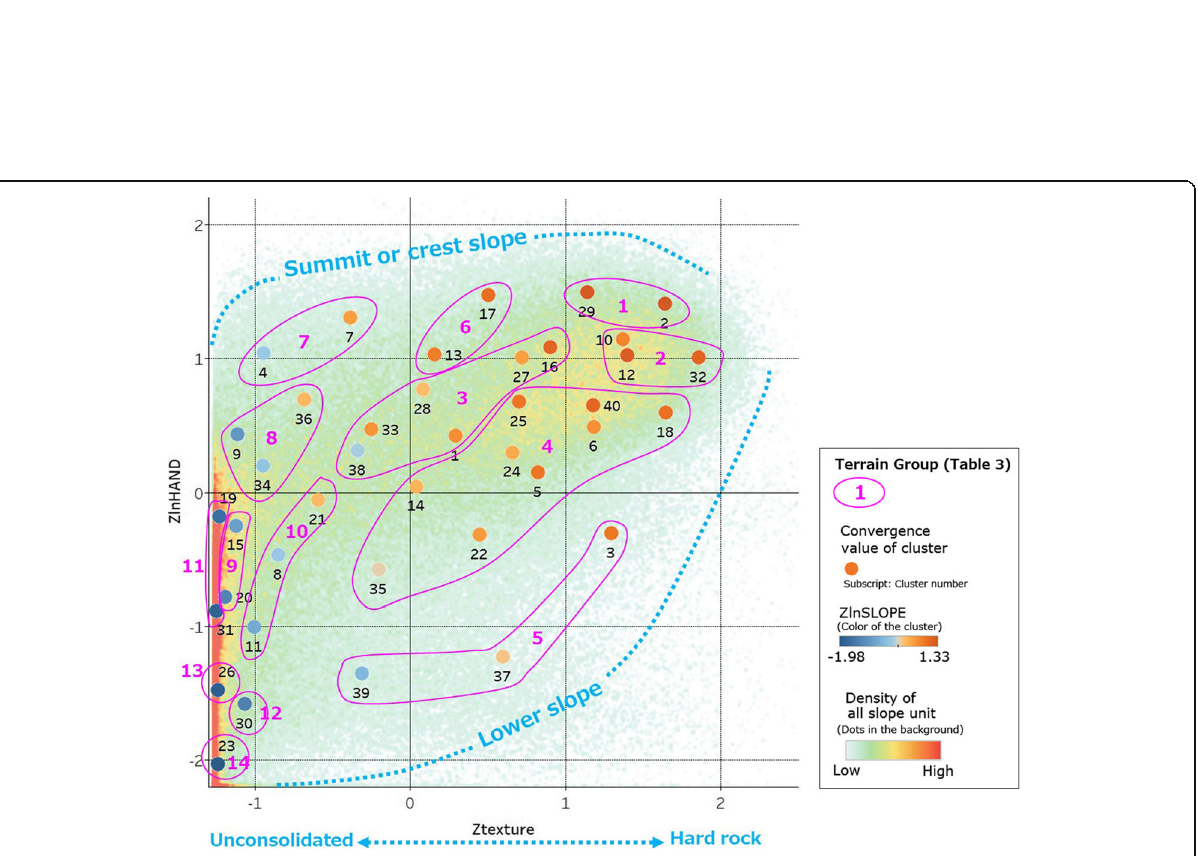
Fig. 11 Basic grouping and inferred terrain types of the